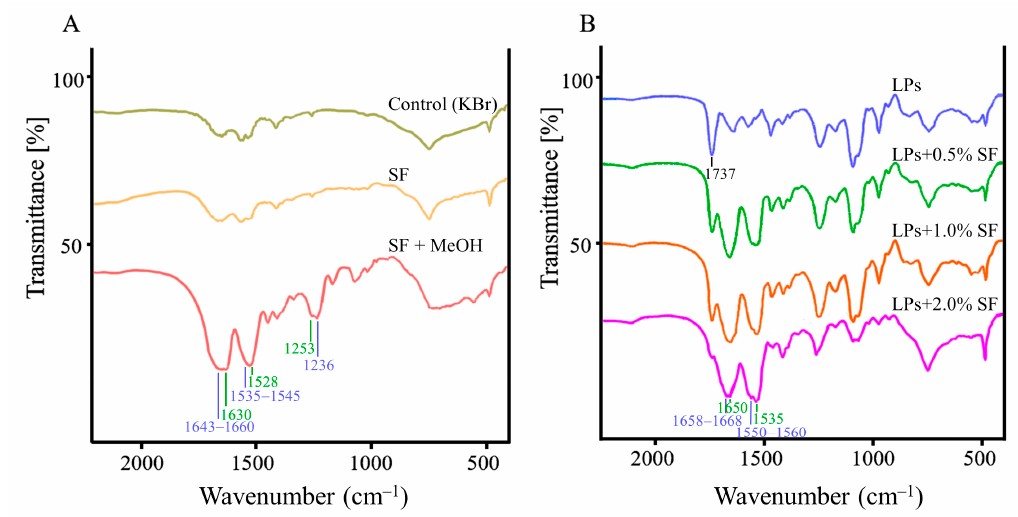
Figure 3. FTIR spectra of SF and SF-LPs. ( A ) SF with and without treatment of methanol; ( B ) uncoated liposomes and SF-LPs using SF of 0.5–2.0%.